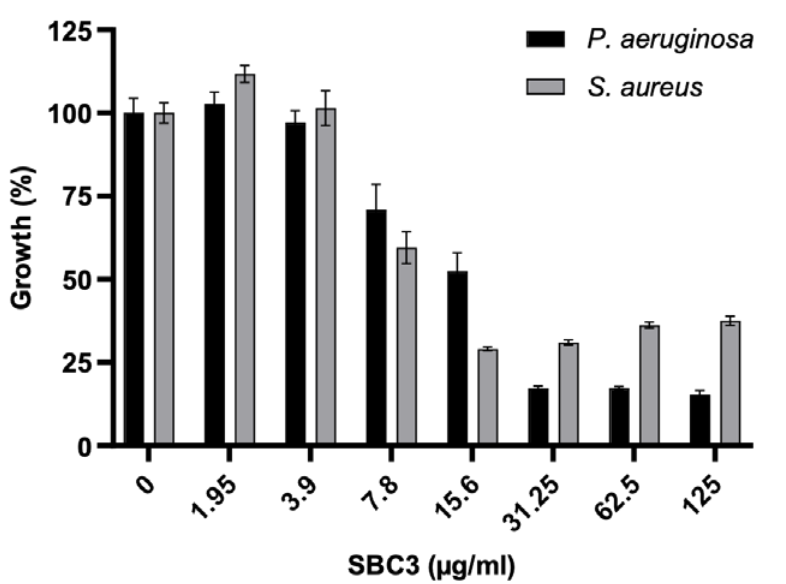
Figure 1. Evaluation of the effect of SBC3 on the growth of P. aeruginosa and S. aureus . All values are the mean ± S.E. of three independent experiments.